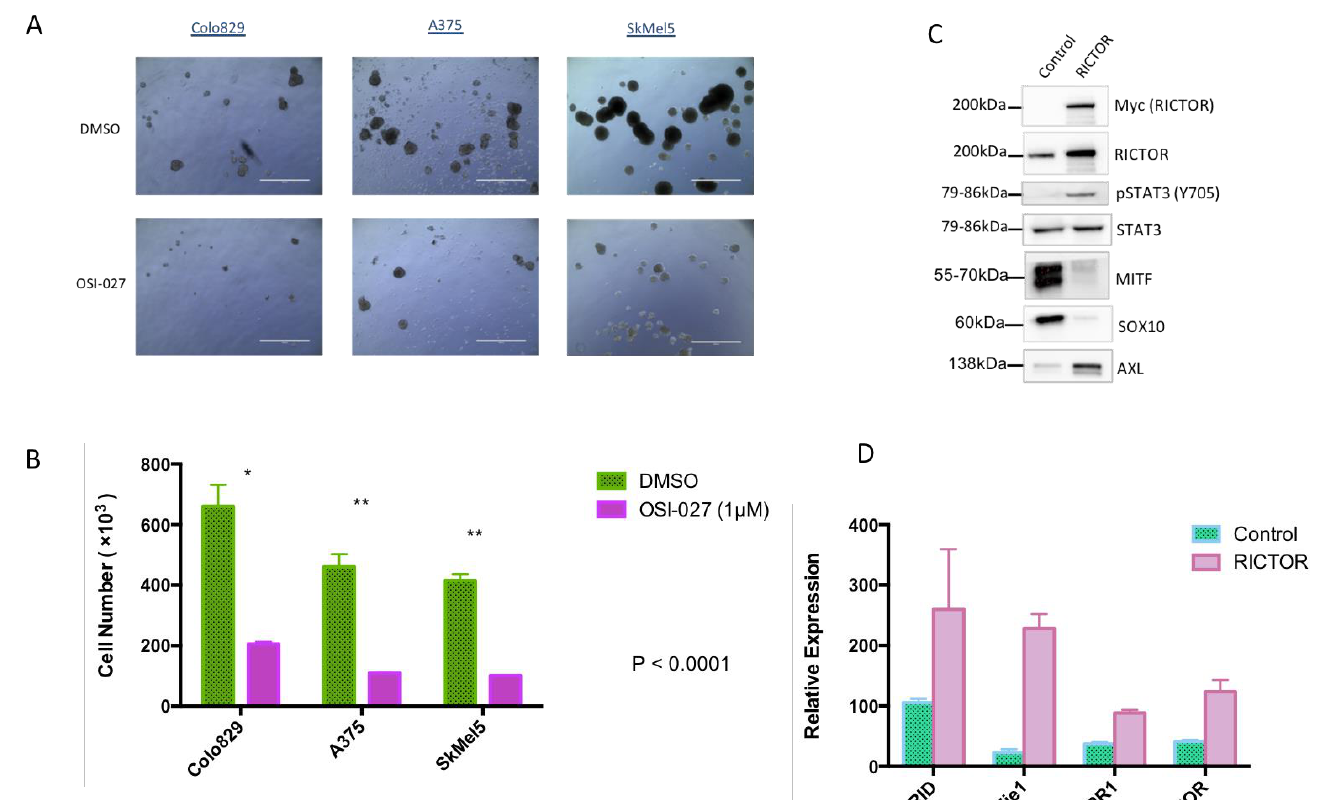
Figure 3. RICTOR-mediated melanoma spheroid growth induces an MIC phenotype ( A , B ) Colo829, A375, and SkMel5 cell lines were cultivated under the same condition as Figure 2 and treated with DMSO or an mTOR inhibitor (OSI-027 1 µ M) for 10 days and counted (scale bar represents 1000 μm). Graphs represent the mean ± s.d. of an experiment in triplicate (similar results were obtained in three independent experiments). Significance was calculated using the Student’s t -test: * p < 0.05, ** p < 0.01. ( C ) The expressions of Myc-tagged RICTOR, RICTOR, phosphorylated STAT3 (Y705), total STAT3, MITF, SOX10, and AXL were assessed by Western blotting in Colo829 cells transfected with an empty vector (Control) or with a vector expressing human RICTOR cDNA (RICTOR). ( D ) Relative mRNA expressions of the different tumor-initiating cell markers (JARID, Tie1, and BMPR1), as well as RICTOR, were assessed by qPCR and normalized to GAPDH in Colo829 cells transfected with an empty vector (Control) or with a vector expressing human RICTOR cDNA (RICTOR).